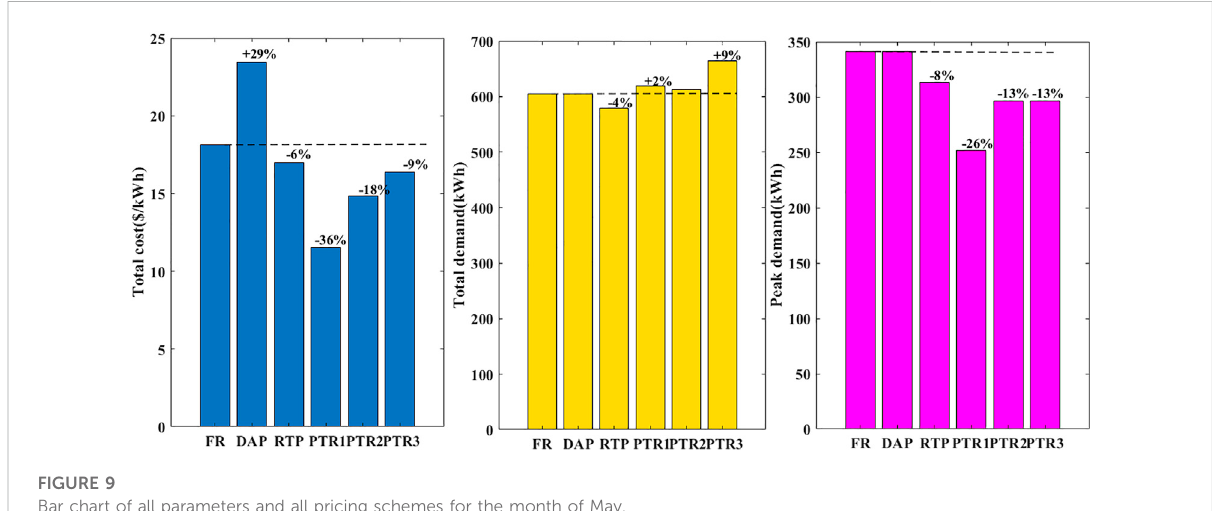
FIGURE 9 Bar chart of all parameters and all pricing schemes for the month of May.